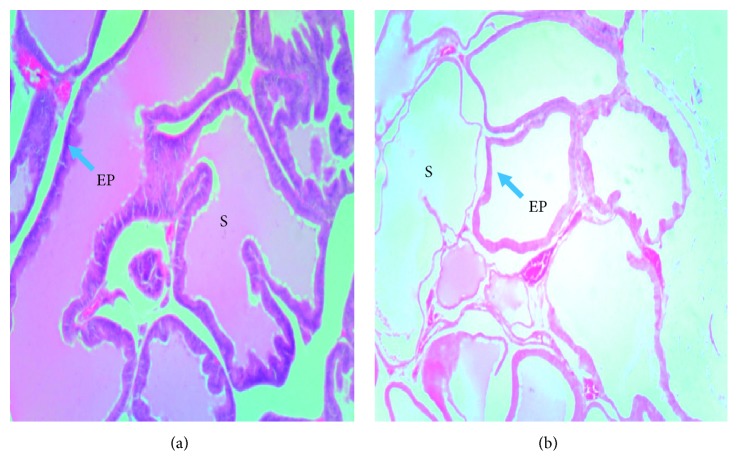
Photomicrograph of prostate glands of experimental rats after testosterone-induced benign prostatic hyperplasia: prostatic secretions (S); epithelium (EP). (a) Testosterone-injected group. (b) Sham group. The testosterone-injected group had thicker epithelium, larger acini, and more prostatic secretions. Sham group had thinner epithelium and fewer prostatic secretions.